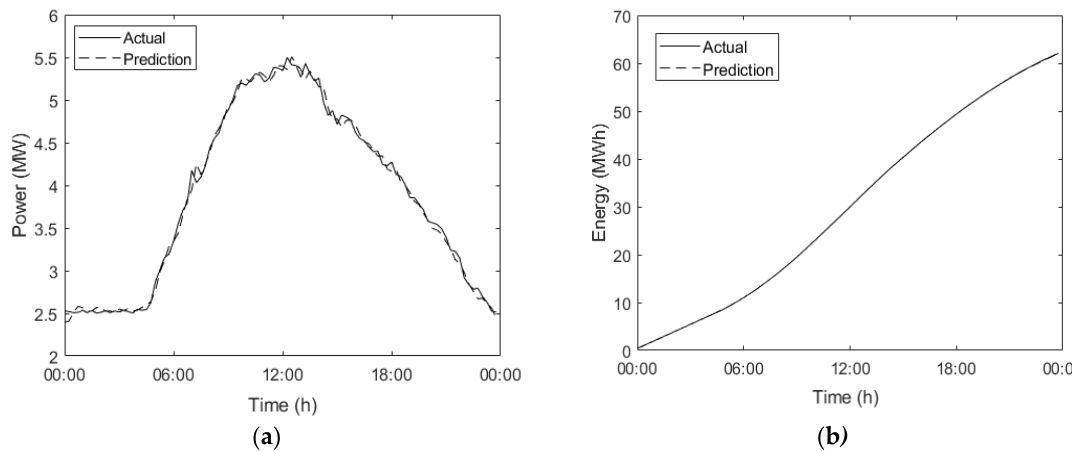
Figure 8. ( a ) Difference between real and predicted power demand on 31 August 2018 ( b ) accumulated